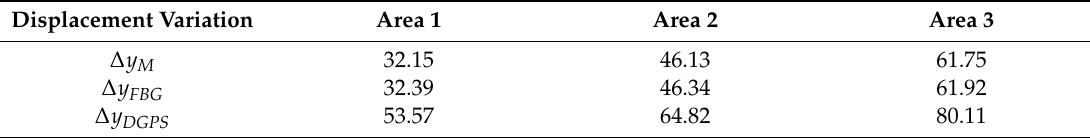
Figure 17. The system of a1 and a2 displacement change diagram. Table 3. Comparison results of wing deformation measurement (mm). Table 3. Comparison results of wing deformation measurement (mm).